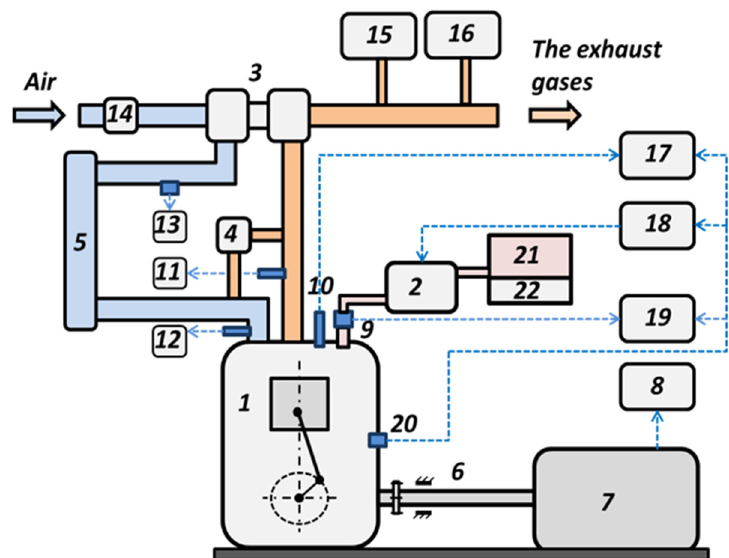
Figure 1. The scheme of engine testing equipment: 1—1.9 TDI engine; 2—high pressure fuel pump;